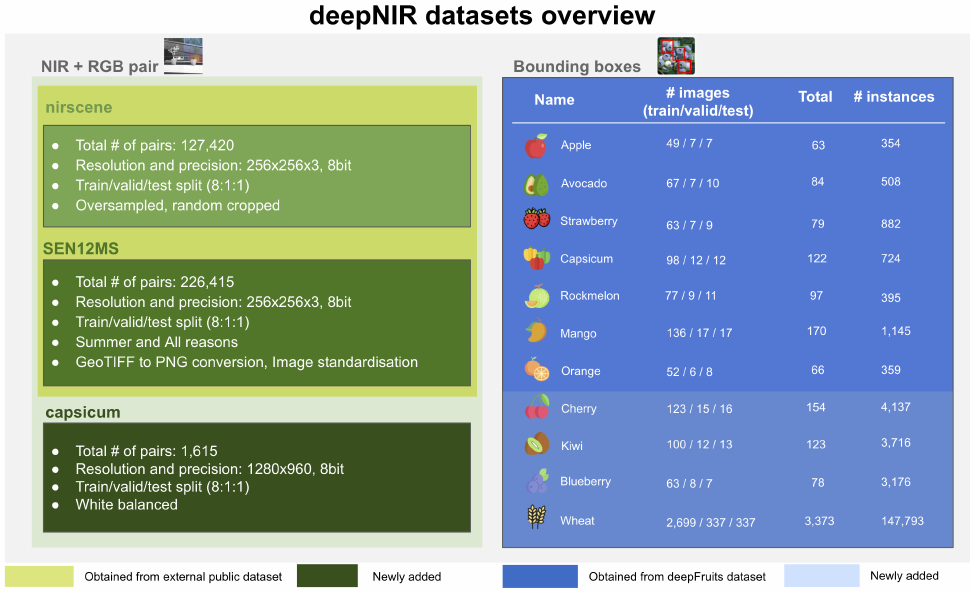
Figure 2. NIR+RGB pair and object detection datasets